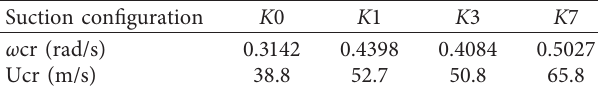
Table 3: Flutter critical frequency and wind